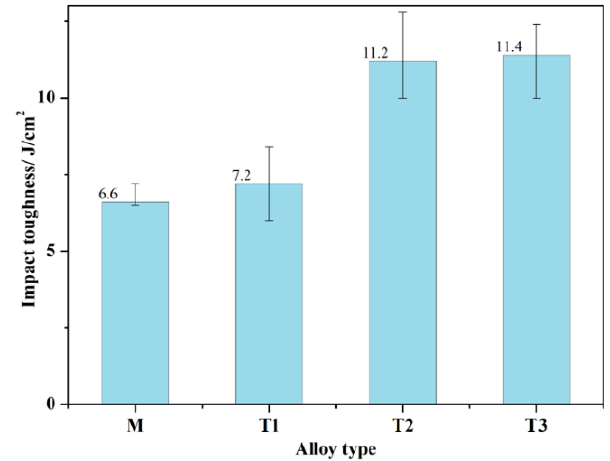
Figure 11. Toughness results of high-boron multi-component alloy.